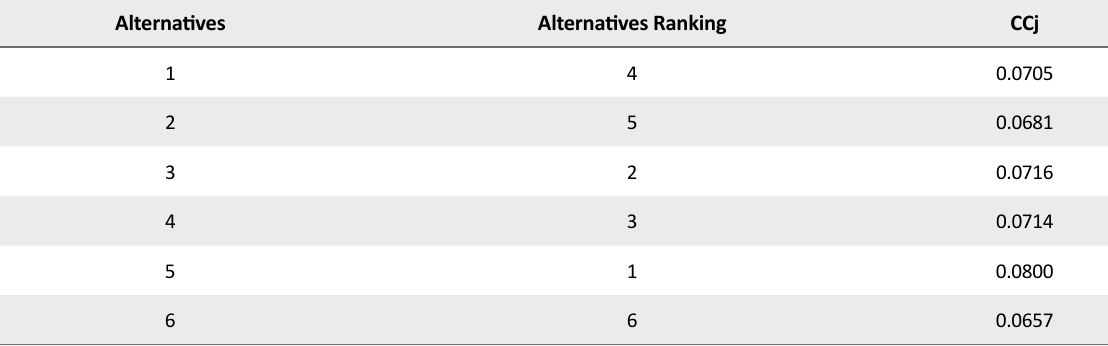
Table 13. Relative proximity of each alternative to the negative and positive ideal solution and prioritization of alternatives based on the Fuzzy TOPSIS method